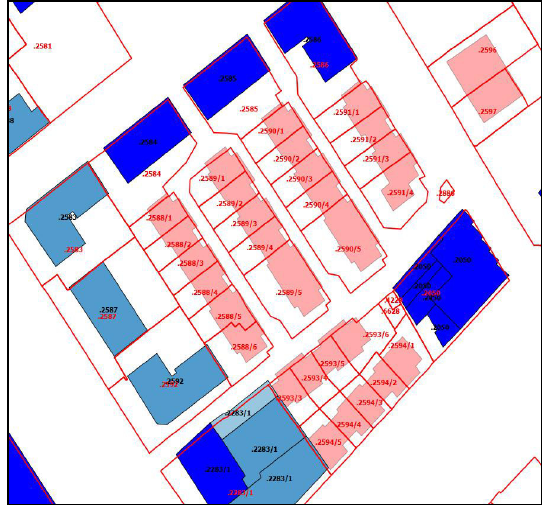
Figure 4 Example of overlay and intersection between land cadastre parcels (red lines, with IDs) and topographic map polygons. The pink polygons need to be split, as they cover multiple cadastre IDs. Cadastral IDs are assigned automatically to the polygons the other polygons, depending on the ratio of overlapping